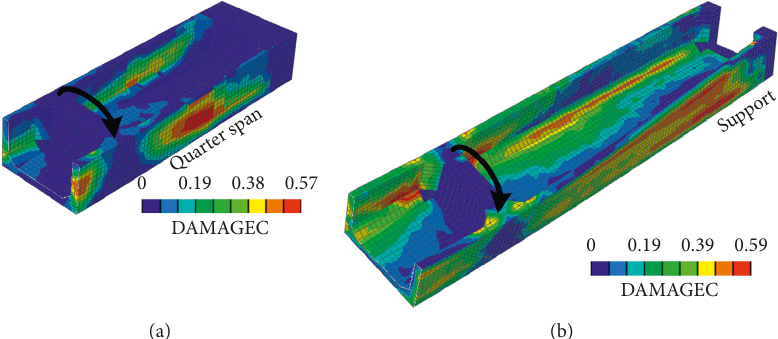
Figure 16: Two typical simulated results with the largest DAMAGEC at shear critical segment: (a) fixed-fixed supported SL-CL ratio 2.0 case and (b) simply supported SL-CL ratio 3.5 case.